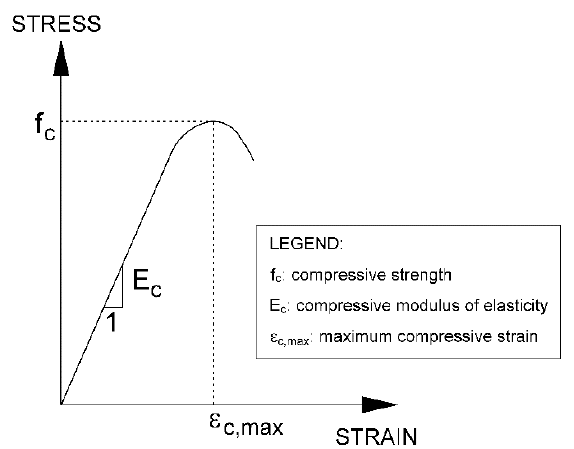
Figure 3. Definition of the three main mechanical parameters.